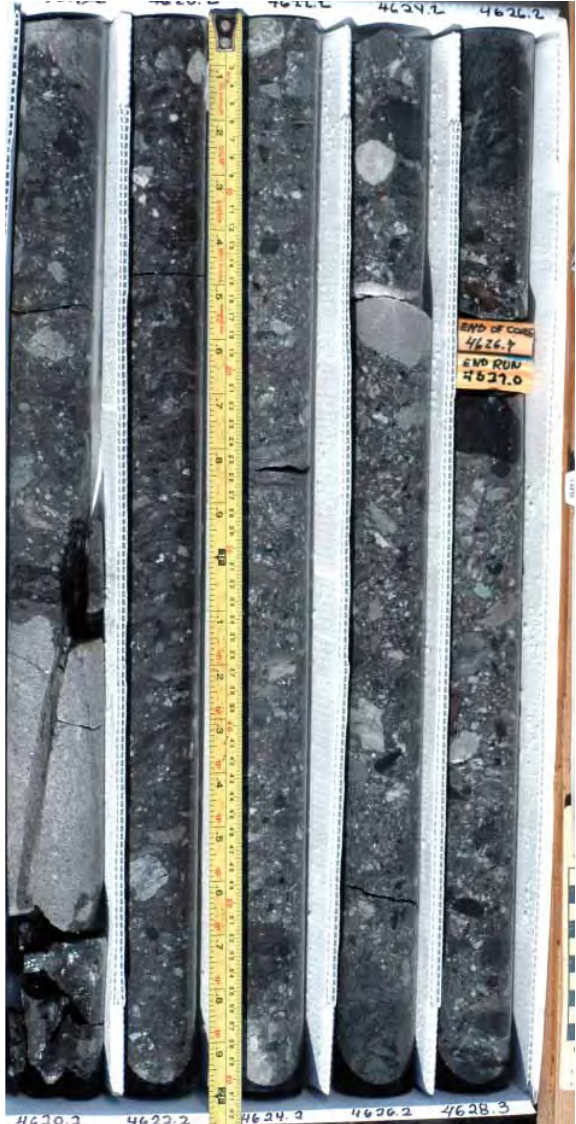
Figure 4. Suevitic and lithic breccia from Eyreville B